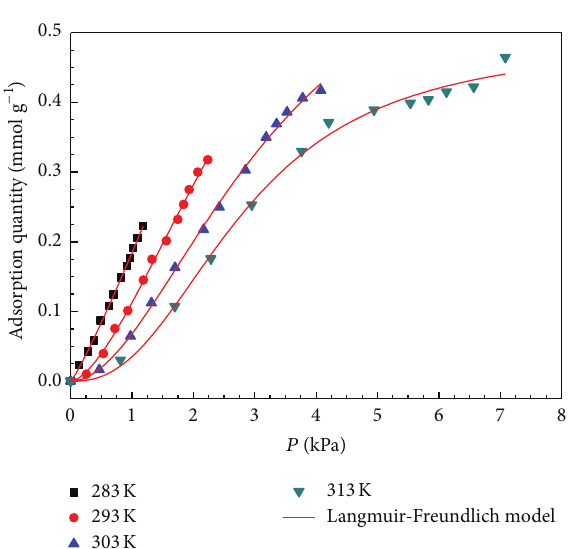
Figure 6: Langmuir-Freundlich isotherms of water vapor on the synthesized MFS-02 at different temperatures.